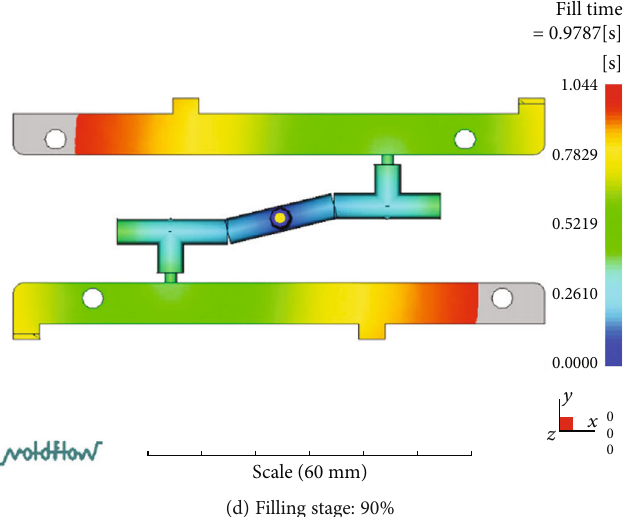
Figure 5: Numerical simulation of the short shot with thin-wall injection molding.